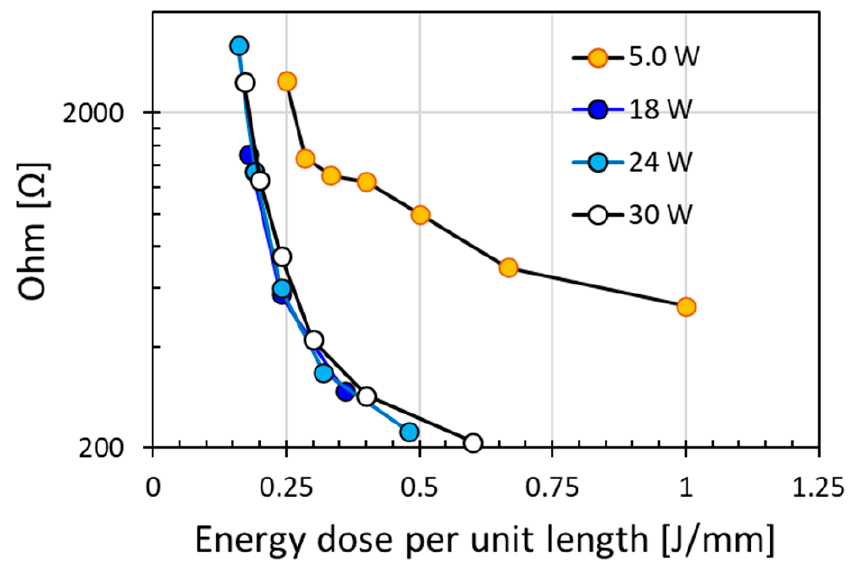
Figure 3. Electrical resistance increased with energy dose per unit length applied to irradiate polyimide surface for a single pass scanning at various laser powers (5, 18, 24, and 30 W gave 3.44, 12.40, 16.54, and 20.67 W/cm 2 , respectively).